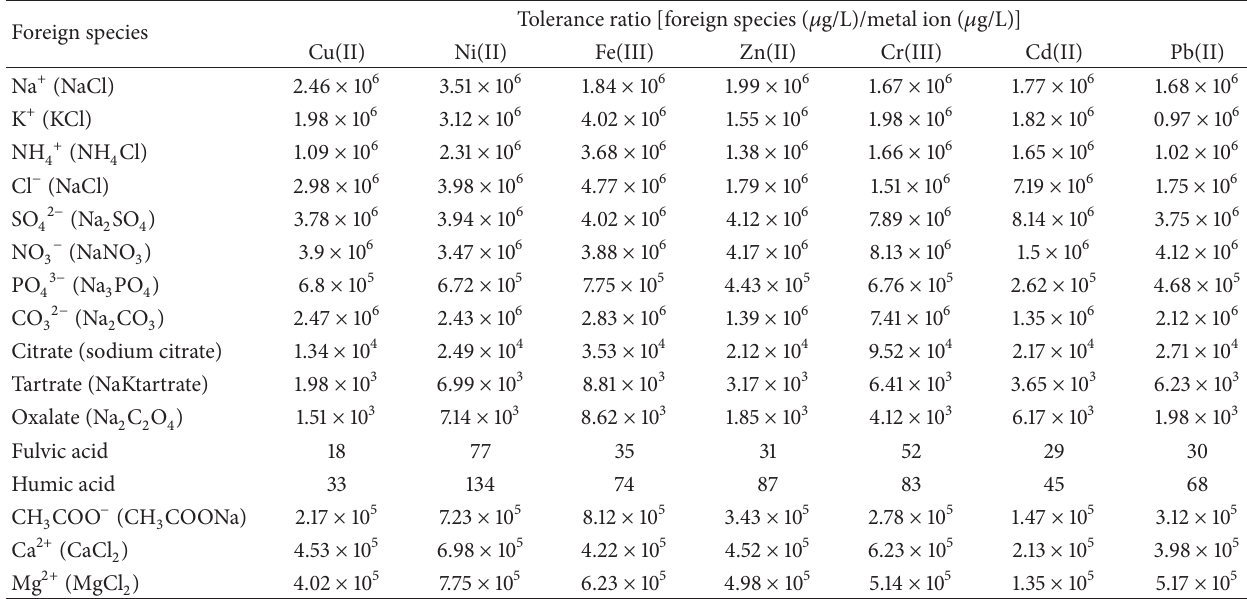
Table 3: Tolerance limit of foreign species (in binary mixtures) on sorption of metal ions (column parameter: 100mL of solution; 10 𝜇 g/L metal ions; 0.5 g resin).